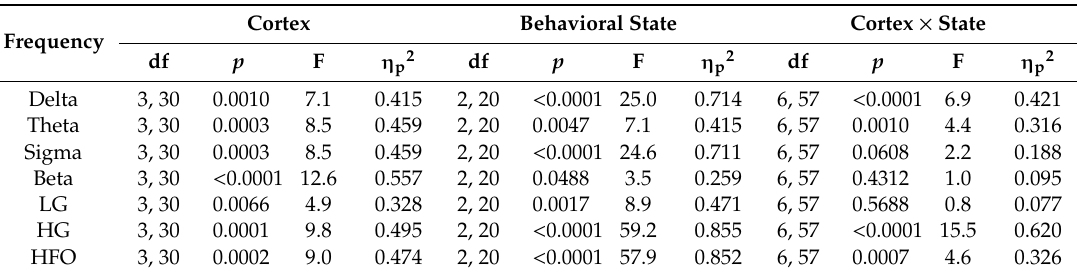
states and electrode